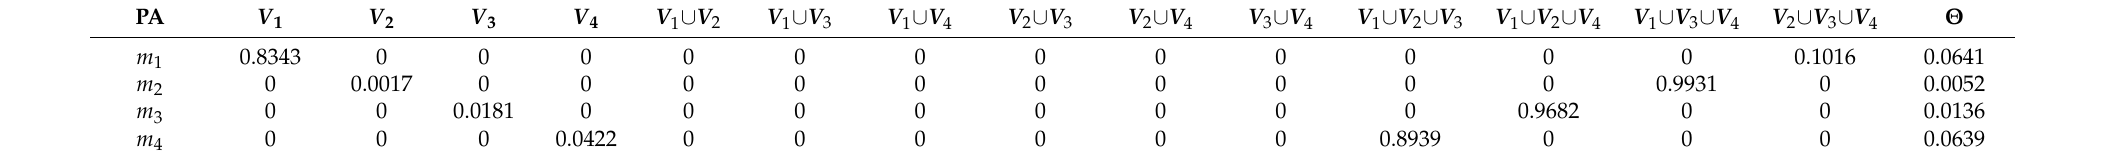
Table 6. The result of first-level fusion for an image without a crack based on OAR classifiers.